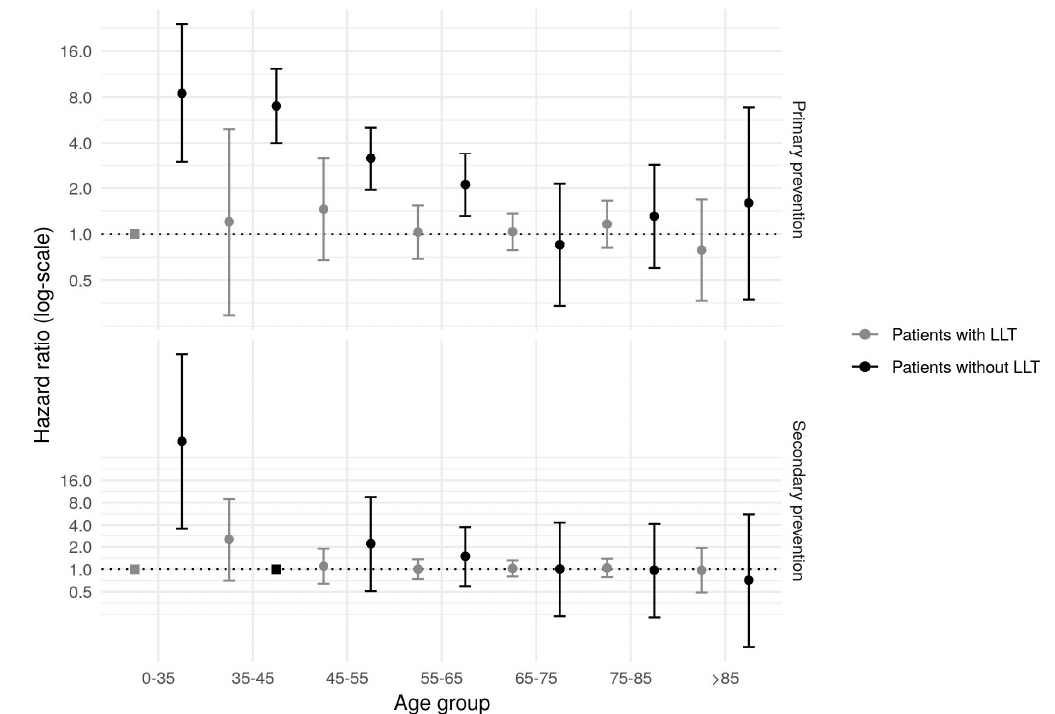
Figure 2. Effect of the presence of Familial Hypercholesterolemia phenotype by statin use, in primary and secondary prevention. LLT: Lipid-lowering therapy. All the models in primary prevention have been adjusted for age, sex, presence of hypertension, diabetes mellitus, smoking, and presence of obesity. Adjustment for disease characteristics (progressive or recent) has been added in the secondary prevention models. The models of patients with lipid- lowering therapy have been further adjusted by statin potency and adherence to treatment (medical possession ratio).